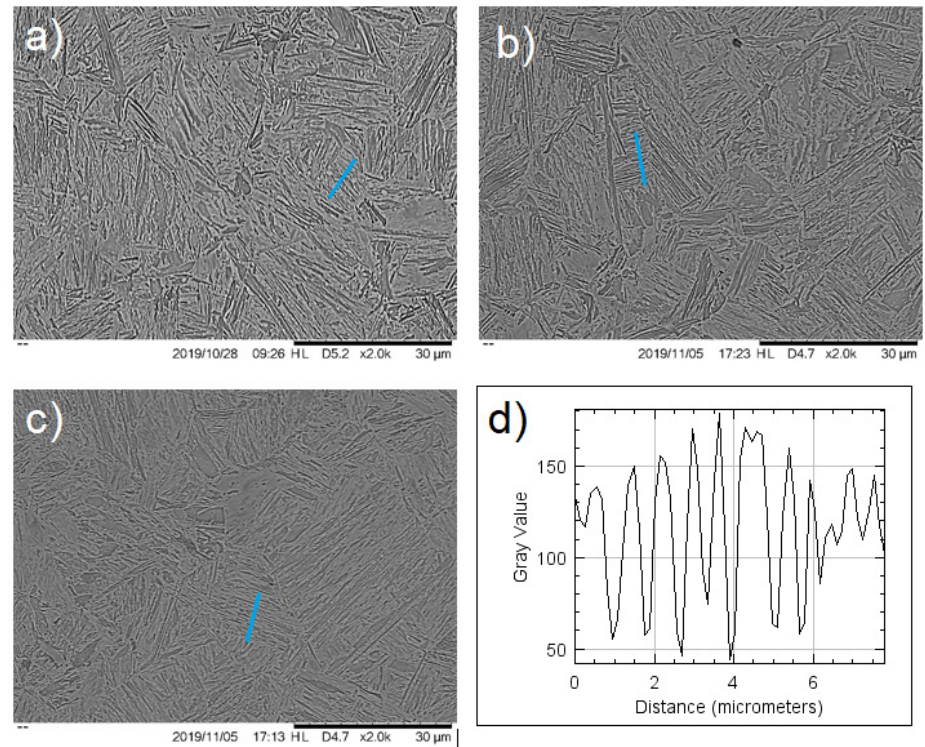
Figure 4. Micrograph of the upper zone for the deformed (1100 °C) and quenched 8620 steel bar at the center ( a ), the middle ( b ) and near the surface ( c ), and lamellar spacing measurement at the center ( d ).